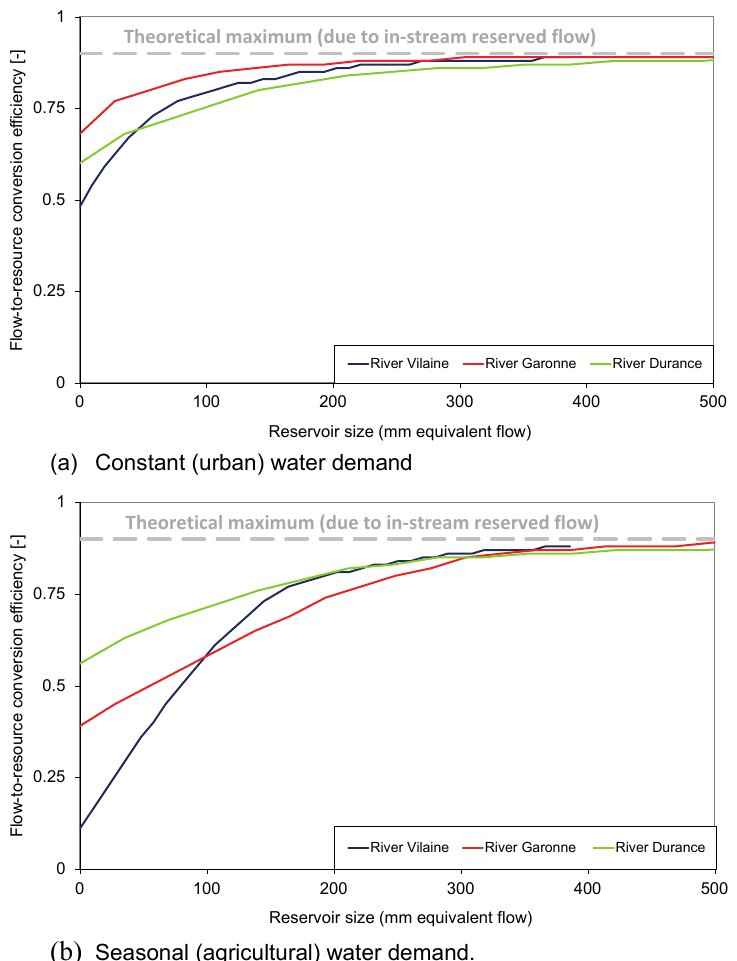
Fig. 4 Impact of a reservoir of increasing size on the flow-to-resource conversion efficiency of three French rivers (reservoir size is expressed as the percentage of the flow module, to allow comparisons between catchments of different sizes and productivity levels). (a) Constant water demand scenario equal to the flow module; (b) seasonal water demand scenario – same total volume as (a). The reservoir simulation takes into account an in-stream reserved flow equal to 10% of the flow